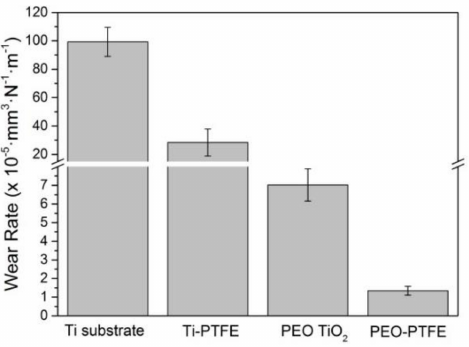
Figure 9. Wear rate of the titanium substrate, Ti-PTFE, PEO TiO 2 coating and the self-lubricating PEO–PTFE composite coating under the load of 4 N and the sliding distance of 100